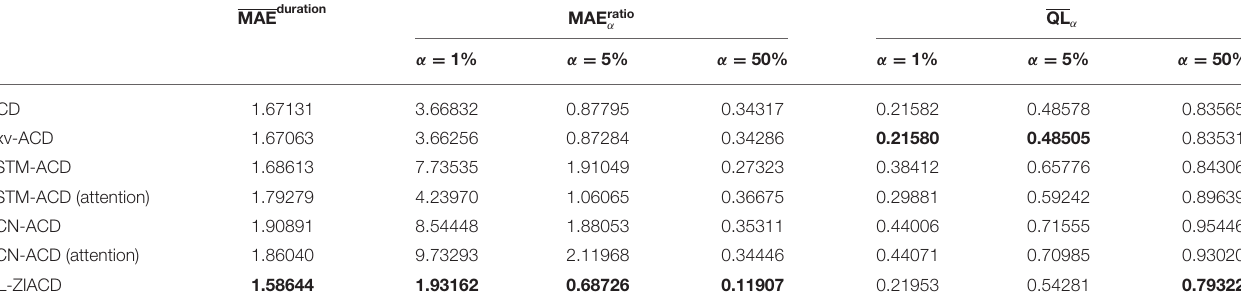
TABLE 1 | Overall performance of distribution